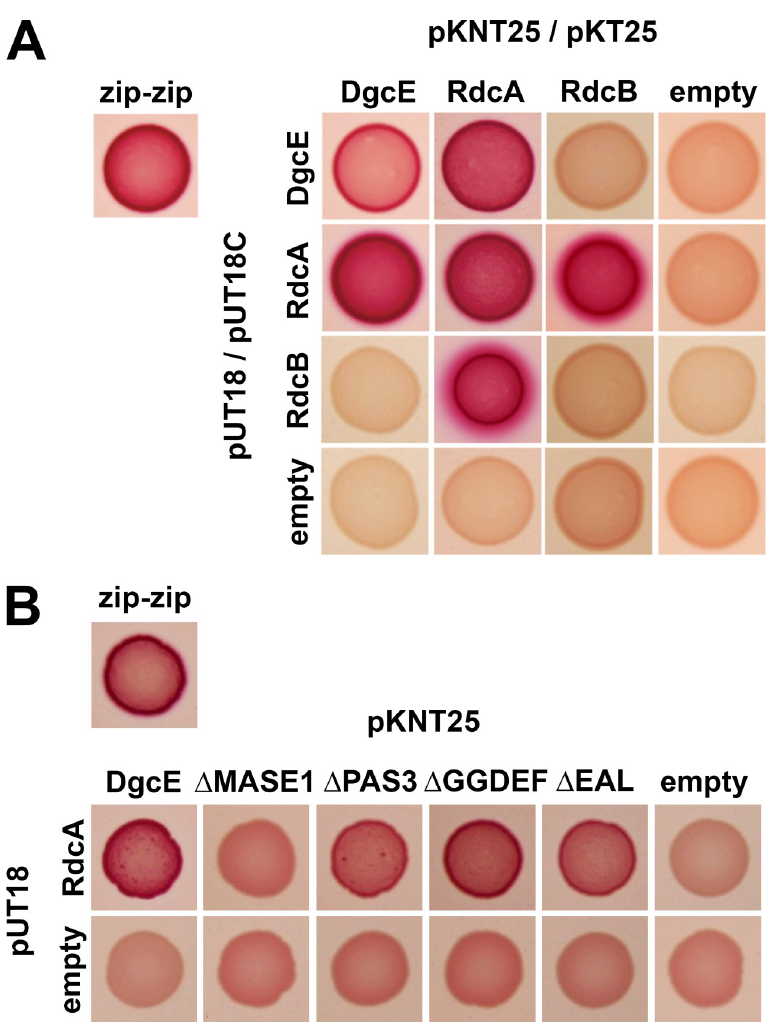
Fig 5. RdcA directly interacts with DgcE and RdcB. A: Two-hybrid interaction assays with the indicated full size proteins. All interactions involving DgcE as well as homodimerization of RdcA and RdcB were tested with fusion proteins that carry the T25 or T18 fragments of adenylate cyclase attached at their C-termini (expressed from pKNT25 or pUT18, respectively). The interaction between RdcA and RdcB was tested with fusion proteins that carry T25 and T18 at their N-termini (expressed from pKT25 or pUT18C, respectively), since the corresponding combination with the adenylate cyclase fragments at the C-termini produced heterogeneously colored transformants. B: Two-hybrid analysis for interaction between DgcE variants lacking single domains and RdcA. ’empty’ stands for the corresponding two-hybrid vector without cloned insert in control